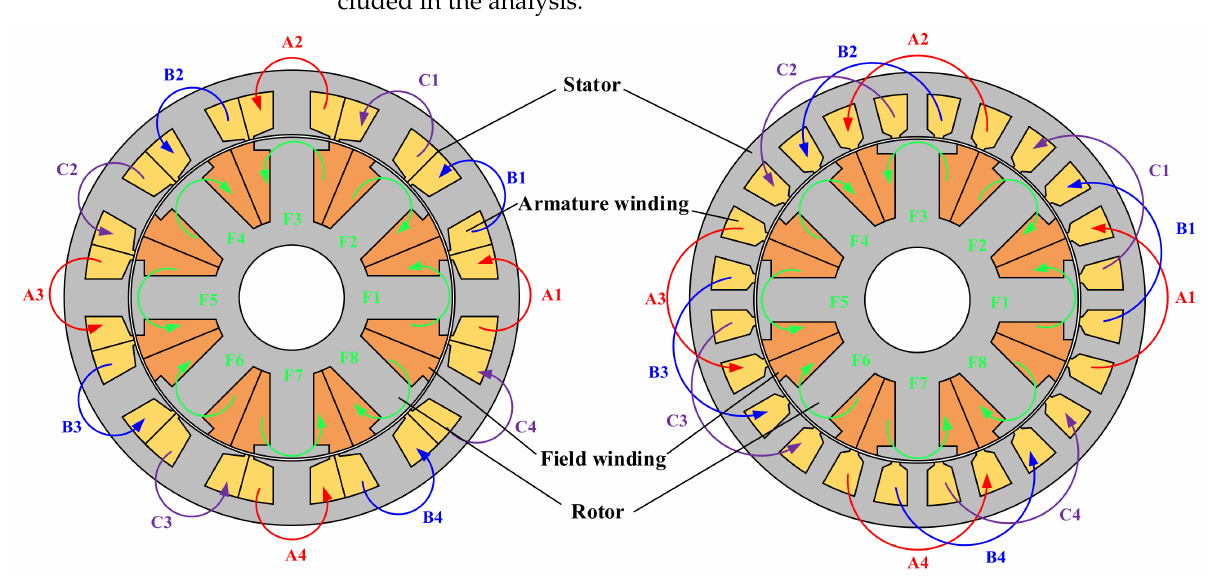
Figure 1. Topology of the analyzed WRSM. (Left: 12-stator slot/4-rotor pole pair, concentrated armature winding. Right: 24-stator slot/4-rotor pole pair, distributed armature winding).